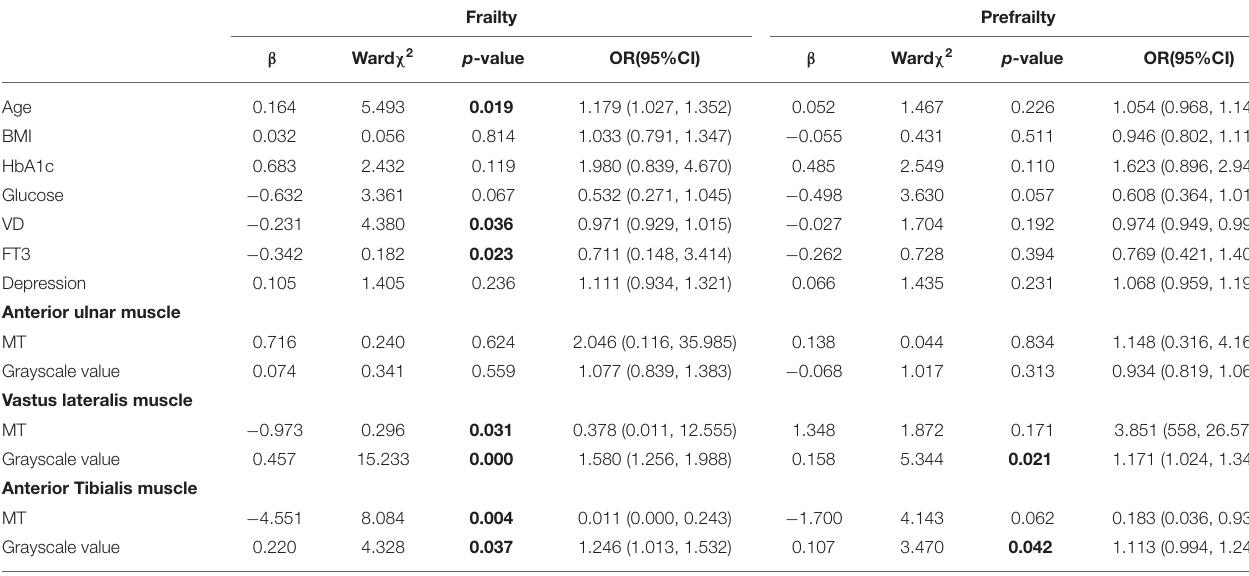
TABLE 3 | Multivariate logistics regression analysis of the effects of muscle thickness and muscle quality of Anterior ulnar muscle, Vastus lateralis muscle and Anterior Tibialis muscle on FFP.